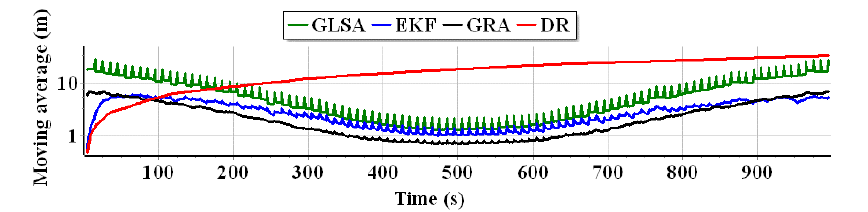
Figure 10. Moving average distance to reference position from the estimated position during 100 SV crossings as a function of time (logarithmic scale—log base =